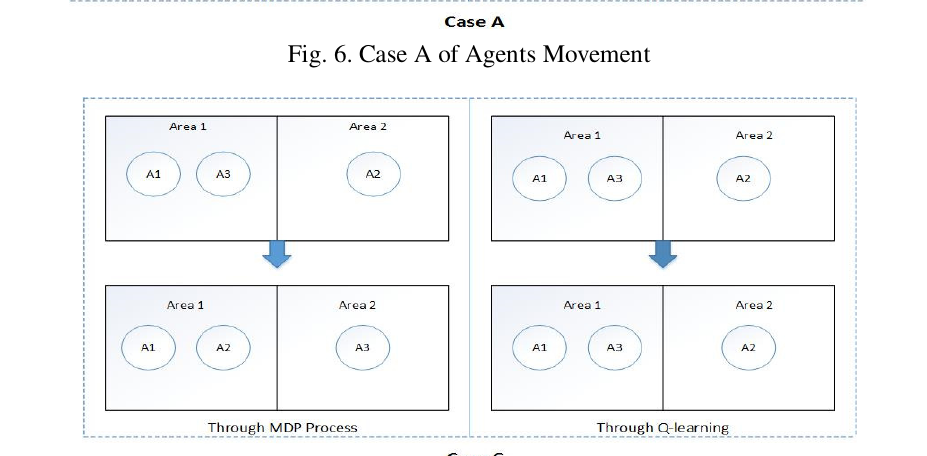
Fig. 6. Case A of Agents Movement